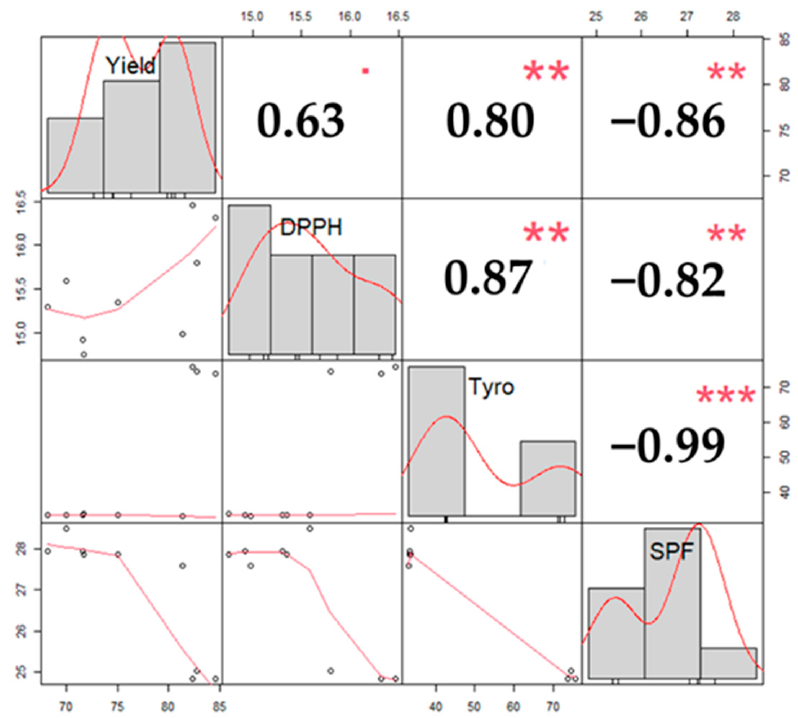
Figure 3. Pearson’s correlation matrix. The diagonal, top right, and bottom left boxes represent the data distribution of each variable, correlation coefficient, and bivariate scatter plot, respectively; *** p < 0.001, ** p < 0.01.